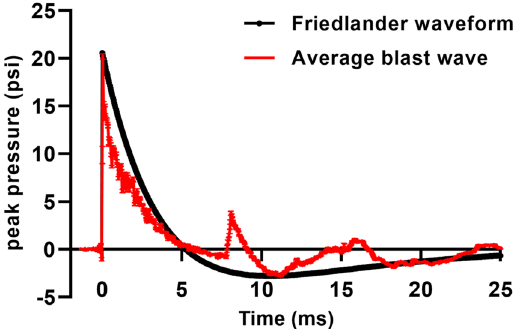
Figure 1. Blast overpressures generated with a well-established pneumatic shock tube simulate a Friedlander waveform expected from high explosives. Red trace denotes the mean waveform of 24 blasts sampled throughout the experiments comprising this report. Black trace shows an estimated Friedlander waveform expected from detonation of approximately 21 kg TNT detonated at a distance of 8 m in the open field. Error bars denote